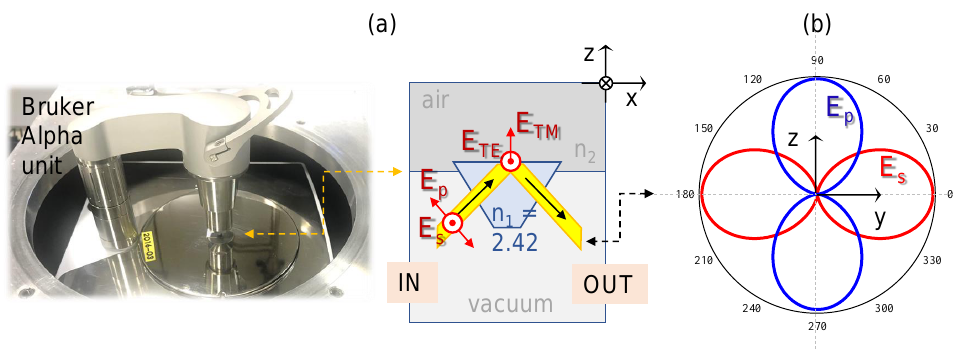
Figure 5. ( a ) Geometry and conventions of ATR; photo of the Bruker Alpha unit setup on the THz- beamline compartment. ATR conventions: incident beam (IN) has E s , p polarisations selected by a wire grid polariser incident on the ATR diamond ( n 1 = 2.42 [29]) prism; plane of incidence is xz. The reflected beam is elliptically polarised due to phase and amplitude changes incurred upon reflection (e.g., air case n 2 = 1). The sample is contributing with absorption and phase change for the output beam (OUT). At the interface (sample) the evanescent field E TM (or E z ) and E TE or ( E y ) defines the light–matter interaction. ( b ) The reflected beam can be expressed via E s , p projections measured analyser and given by Equation (4). The angle ϕ is the orientation of the wire grid polariser in the incidence side (IN); ϕ = 0 ◦ corresponds to pure E s component incident onto the ATR prism. The amplitude span in the polar plot is [0–1]. The two components of the E p and E s are shown separately by the dipole-like figures (each term in Equation